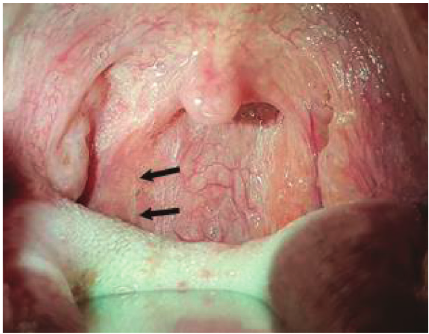
Figure 4: Postoperative (3-months) intraoral view showing complete incision healing (arrows).